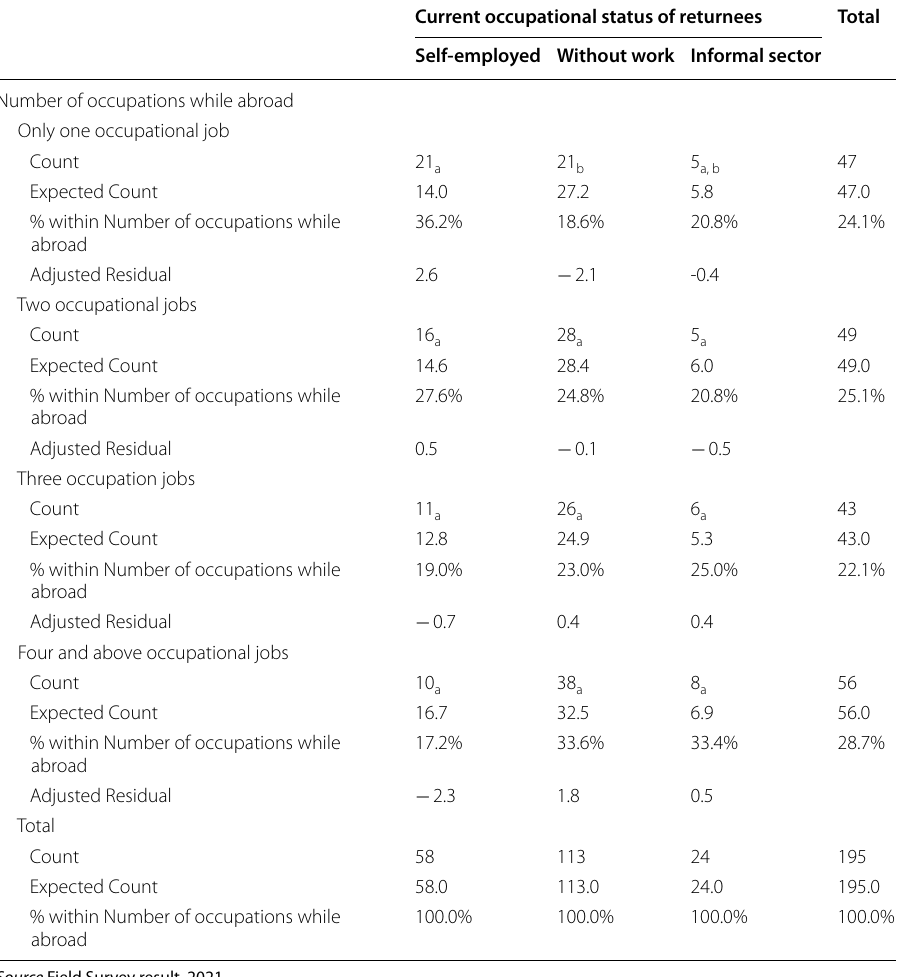
Source Field Survey result,